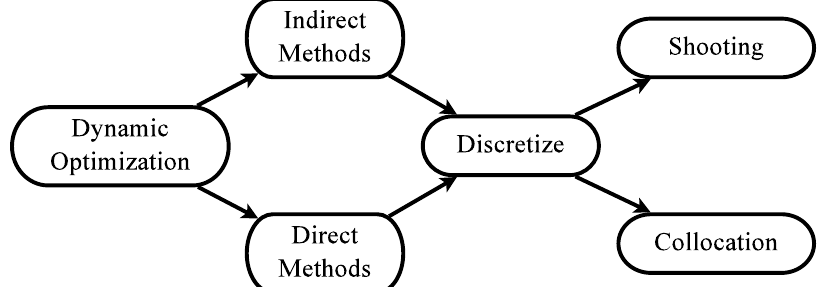
Numerical methods for dynamic optimization. Indirect methods